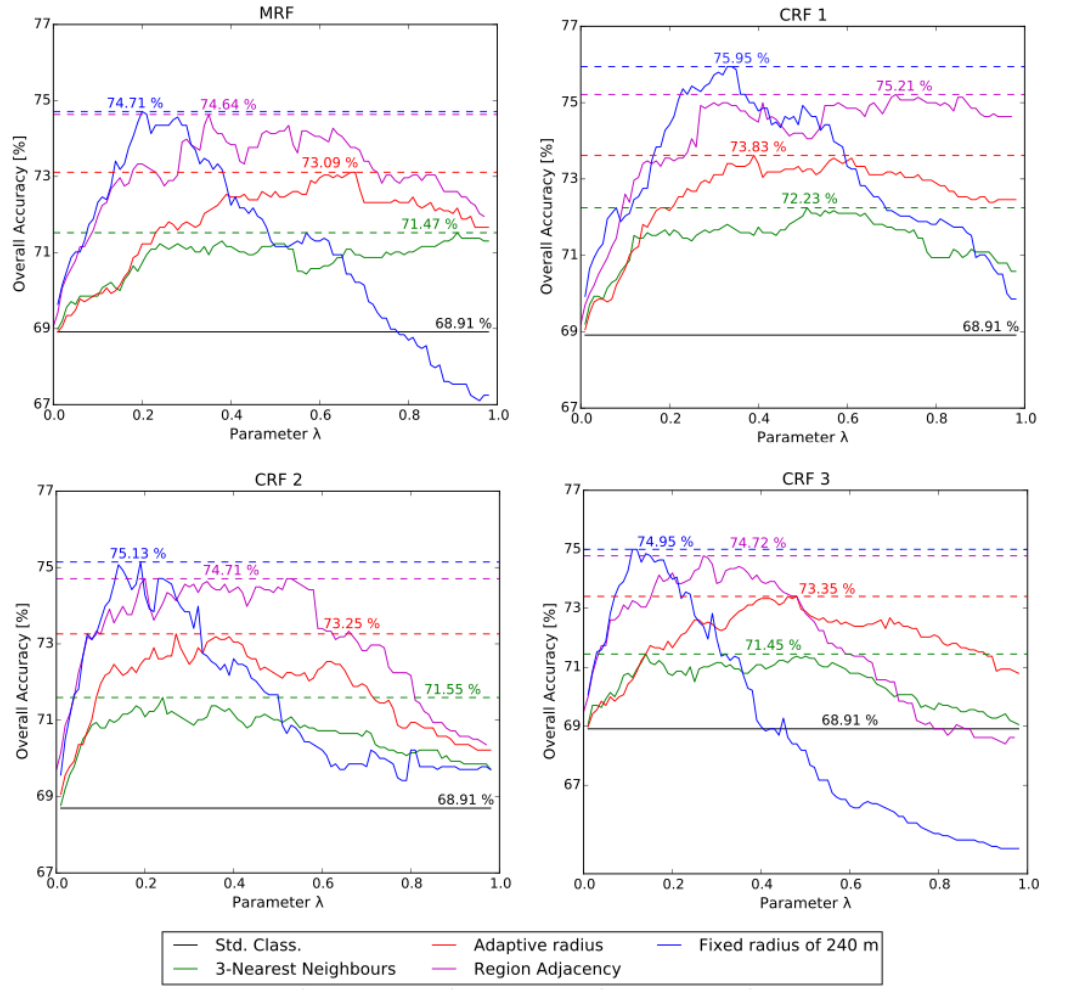
Figure 4. Plot-graphs of the overall accuracies obtained with the four different models explored in this work and with λ parameters varying from 0.01–1.0. The colors of the lines indicate the neighborhood definition